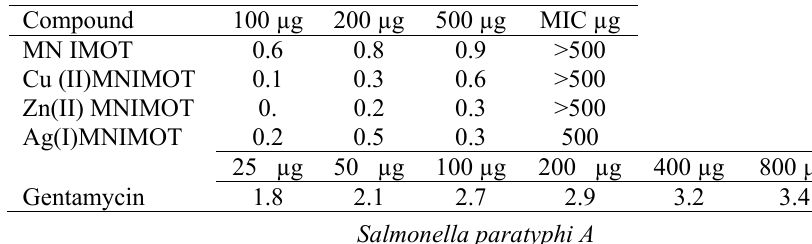
Table 7. Results of Antibacterial activities of ligand (MNIMOT) and its metal complexes Escherichia